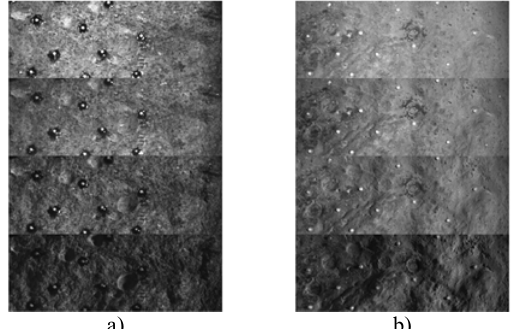
Figure 3. The images show the effect of the four different illumination conditions (from the top the 10° to the last 70° image on the bottom) both for Anorthosite (a) and Concrete (b)